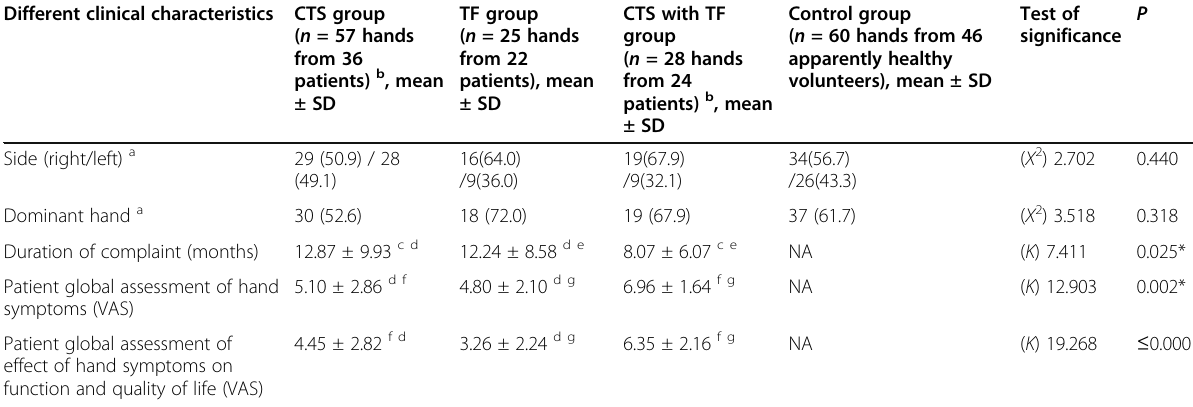
Table 2 Comparison between the three patients ’ groups and control group regarding different clinical characteristics Different clinical characteristics CTS group ( n = 57